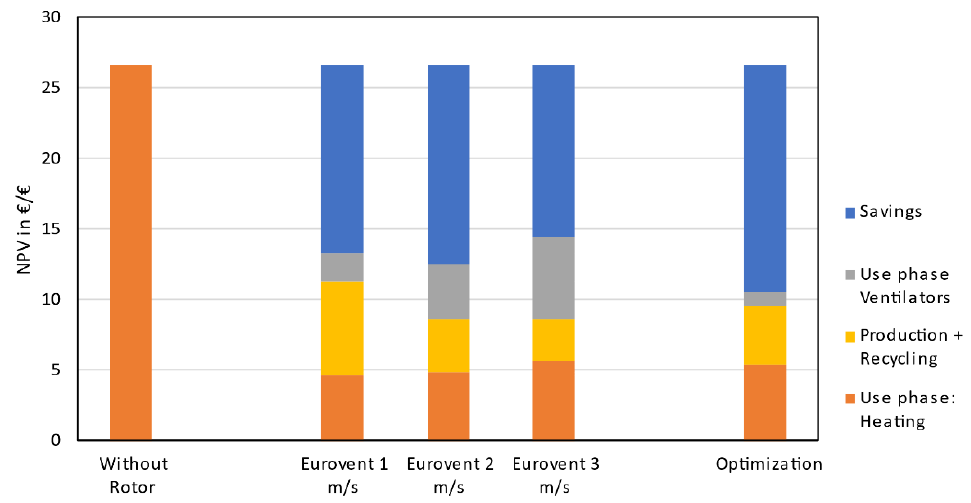
Figure 7. Scenario 0 € /t CO 2 Eq. with optimized RHX and Eurovent RHX under different operating ambient air empty tube velocities at 10,000 m 3 /h.